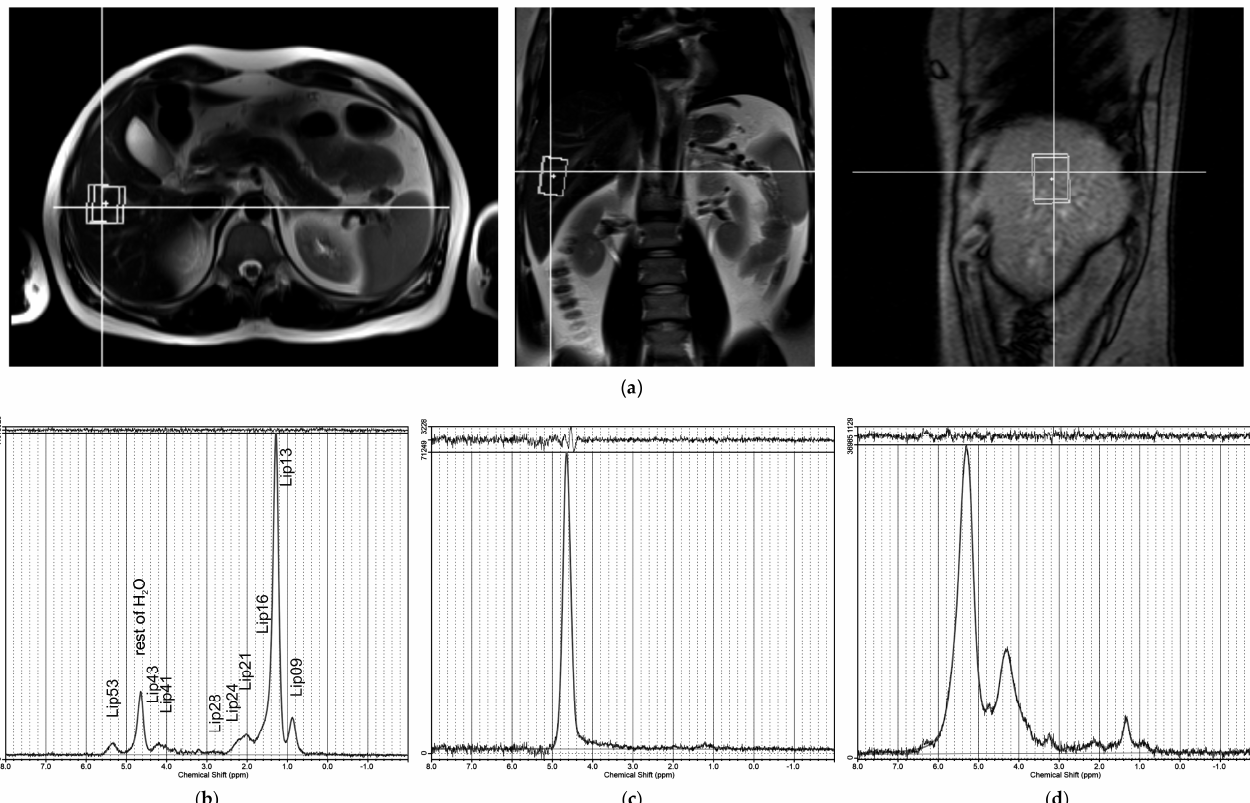
Figure 1. ( a ) Position of spectroscopic voxel (40 × 30 × 25 mm) in the liver for PRESS sequence (TE = 30 ms), with localization based on three orthogonal anatomical MR slices. Examples of LCModel [15] outputs of water-suppressed 1H MR spectra: ( b ) good spectrum quality with signals labelled as per Table 1; ( c ) spectrum excluded from further analysis due to low –(CH 2 ) n – S/N ratio; ( d ) spectrum excluded due to poor shim or movement artifacts.